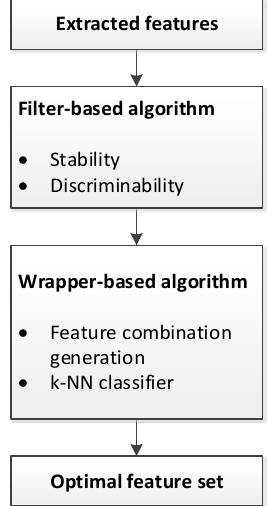
Figure 4. Feature selection procedure